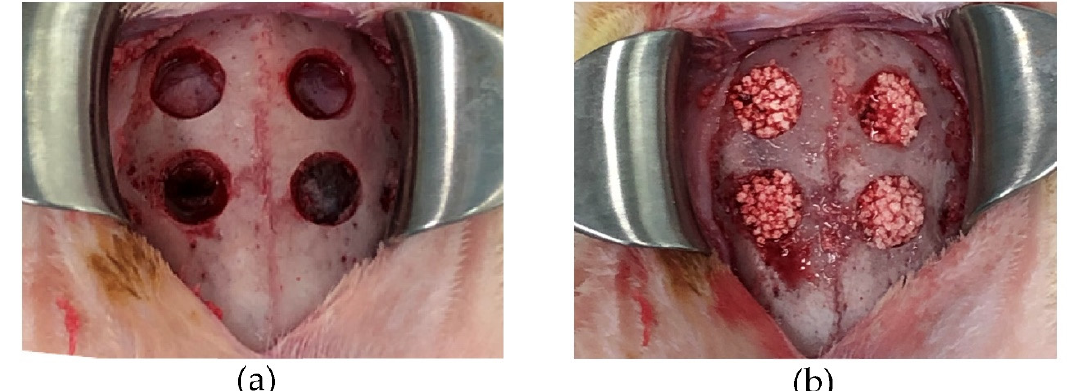
Figure 1. Rabbit cranium before and after filling of bone substitute granules; ( a ) before filling, ( b ) after filling.